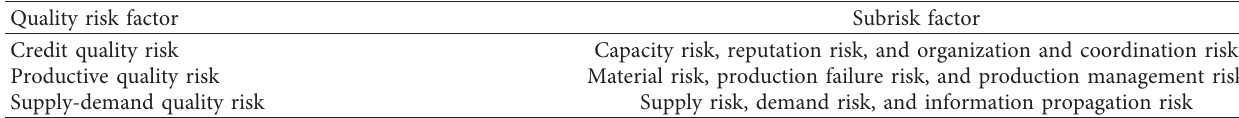
Table 2: Node quality risk